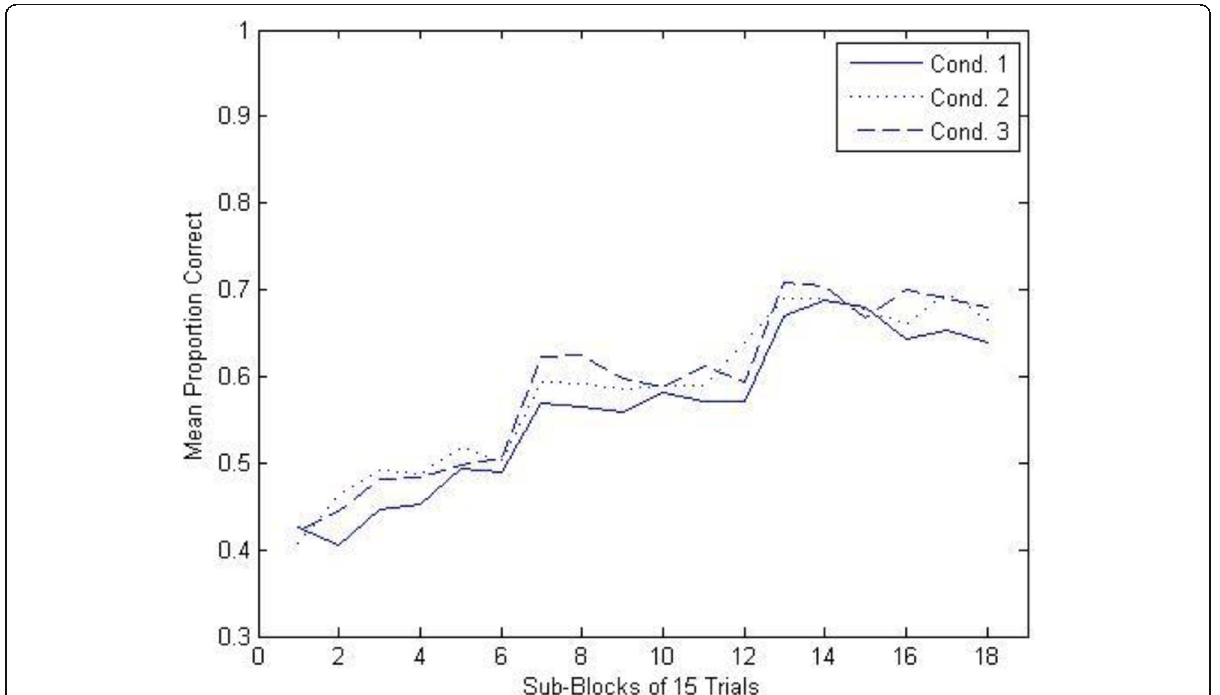
Fig. 6 Experiment 1A: mean proportion of correct high-level classification responses as a function of conditions and sub-blocks during the training phase. Cond.